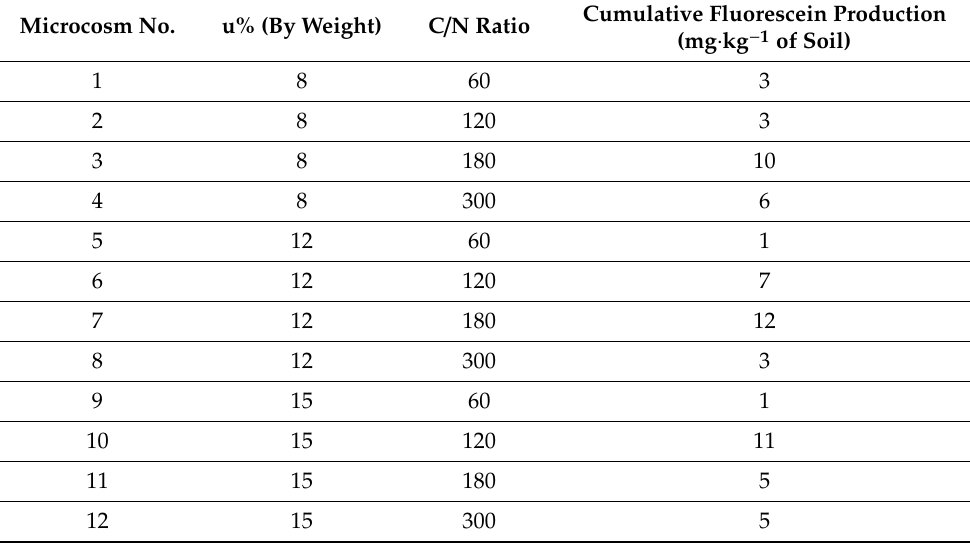
Table 4. Cumulative fluorescein production in 30